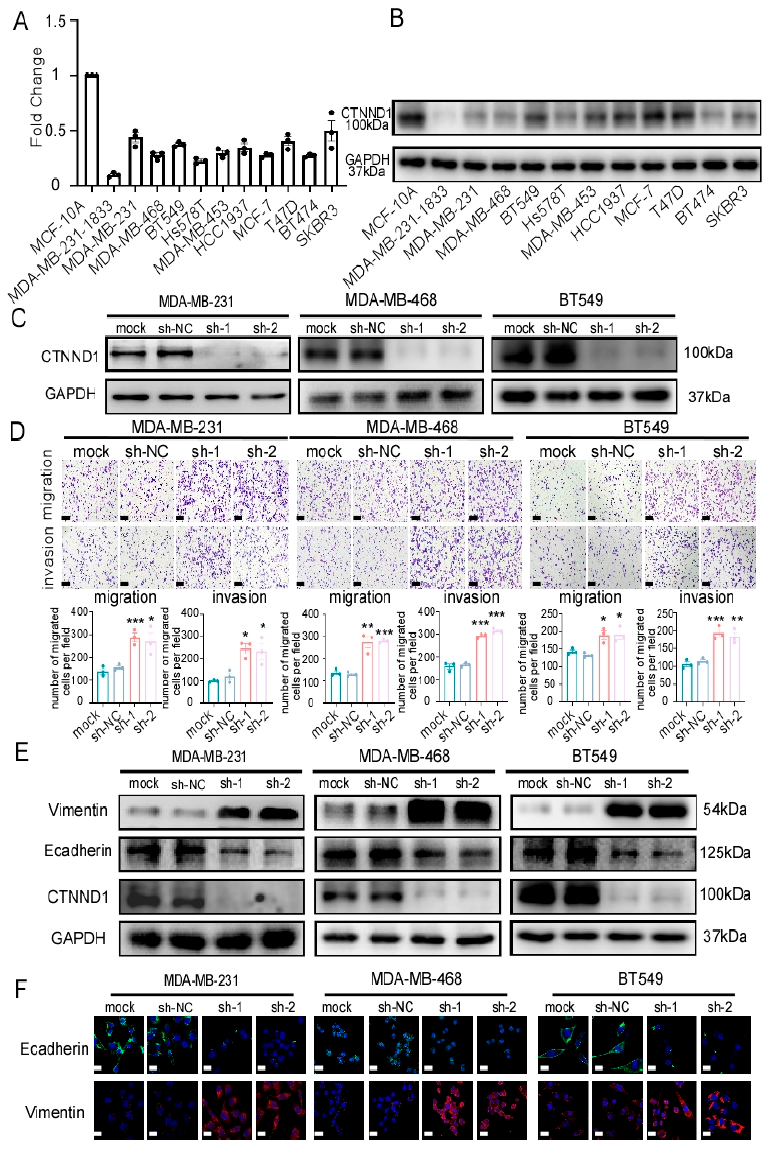
Figure 3. Downregulation of CTNND1 enhances EMT in TNBC cells. ( A ) CTNND1 expression level in human normal breast epithelial cells (MCF-10A) and various breast cancer cells (MDA-MB-231-1833, MDA-MB-231, MDA-MB-468, BT549, Hs578T, MDA-MB-453, HCC1937, MCF-7, T47D, BT474,